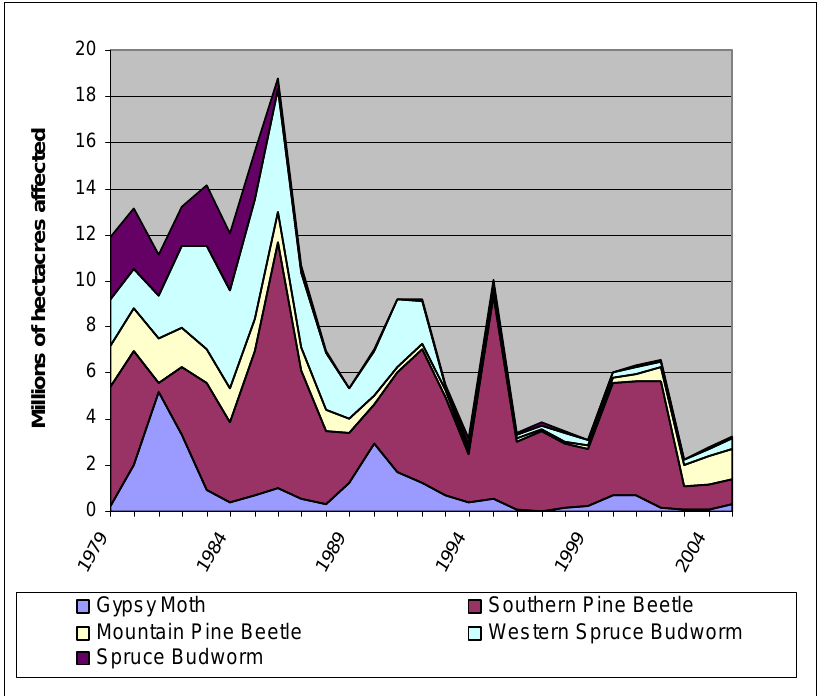
FIGURE 5. Historic trends in forest pest activity in the